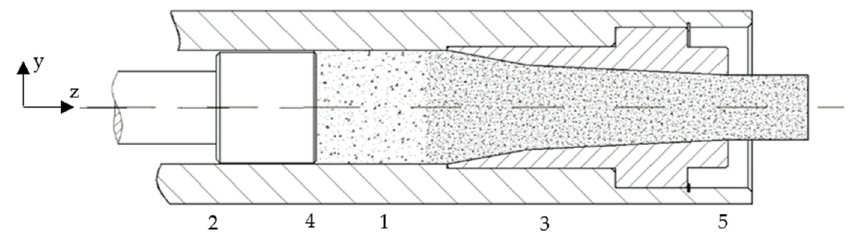
Figure 1. The main part of the piston-type pelletizer. 1—compaction chamber, 2—piston, 3—die, 4—dry ice before compression, 5—compressed dry ice.